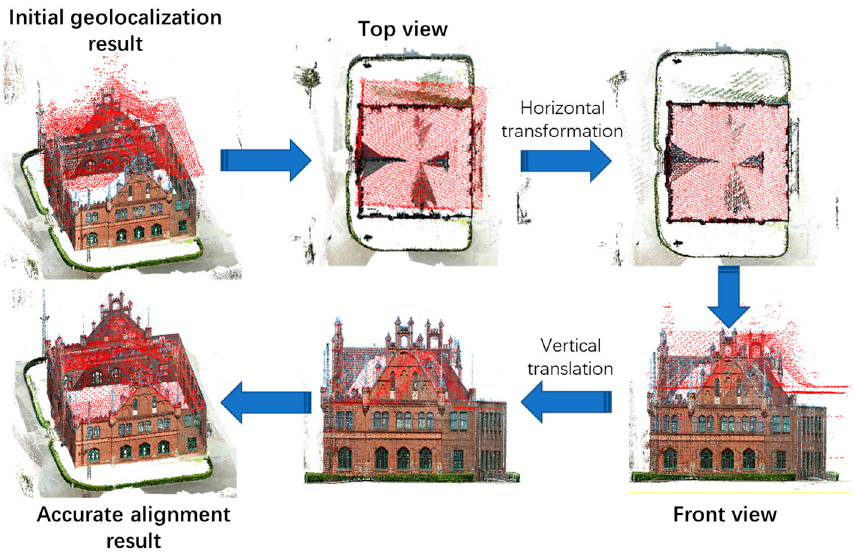
Figure 4. Overview of the proposed accurate alignment process. Red points are building point cloud from open LiDAR data. Textured points are façade point cloud generated from ground images.